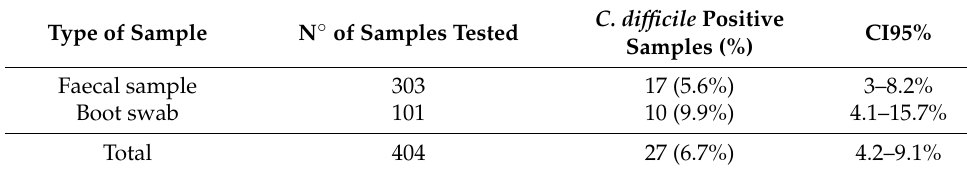
Table 1. C. difficile distribution on different types of samples. Type of